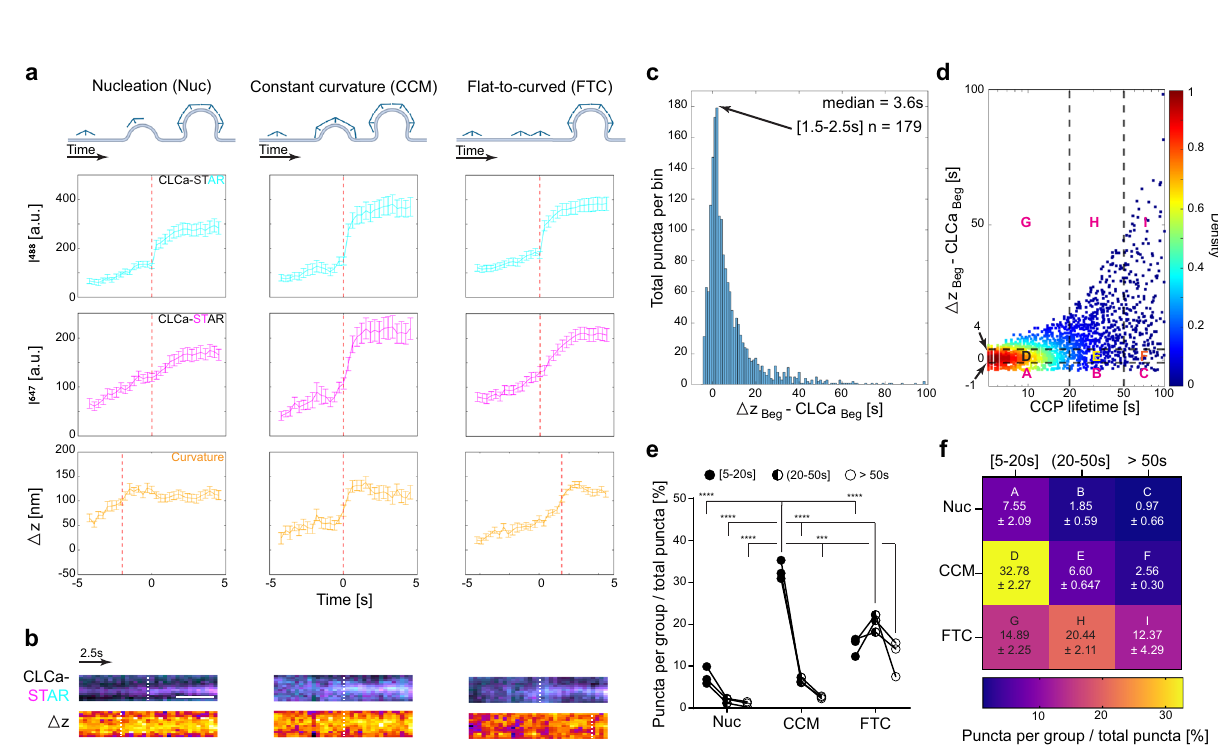
Fig. 2 STAR microscopy identi fi es curved and fl at de novo diffraction-limited clathrin accumulations in Cos-7 cells. a Automated high throughout analysis of live-cell data using CMEanalysis. CLCa-STAR lifetimes in Cos-7 cells separated as positive (left) and negative (right) Δ z, mean ± SEM (EGFP — Cyan, iRFP713 — magenta) (CCVs, n = 1225 events; FCLs, n = 328 events; from 11 cells and three independent experiments). b CLCa-STAR intensity (cyan and magenta) and Δ z ( fi re) for representative CCVs and FCLs across the lifetime cohorts. Scale bar = 1 μ m. c Example CCV and FCL signal traces for the events shown in b . CLCa-STAR intensity: EGFP (Cyan), iRFP713 (magenta) Δ z (Orange), darker shaded band represents the SD of detected signal, lighter colors indicate background mean and 2*SD above background. d Histogram of lifetime distribution of Curved CCS and Flat CCS per µ m 2 , per minute (mean ± SEM). e Cumulative frequency of Curved CCS and Flat CCS per µ m 2 , per minute. Data was not normally distributed as tested by one-sided Shaphiro – Wilk test, black line — median, median for Curved CCS = 0.0065, median for Flat CCS = 0.0015. Medians were signi fi cantly different from one another as tested by two-tailed Mann-Whitney test, exact p < 0.0001 (Data in d , e — Curved CCS, n = 1534 events, Flat CCS, n = 414 events, from 13 cells and fi ve independent repeats).